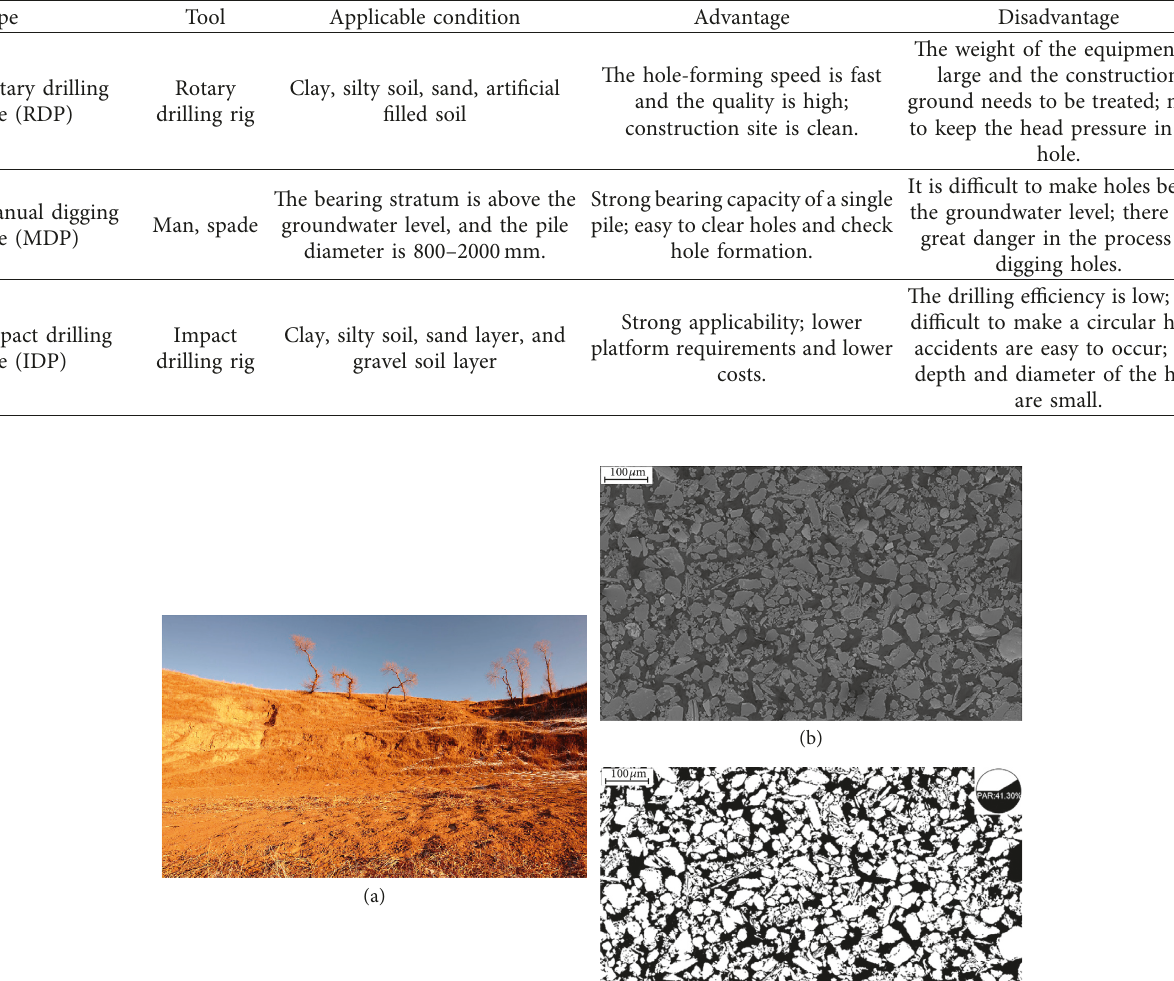
Table 1: Comparison of all 3 types of cast-in-place piles.